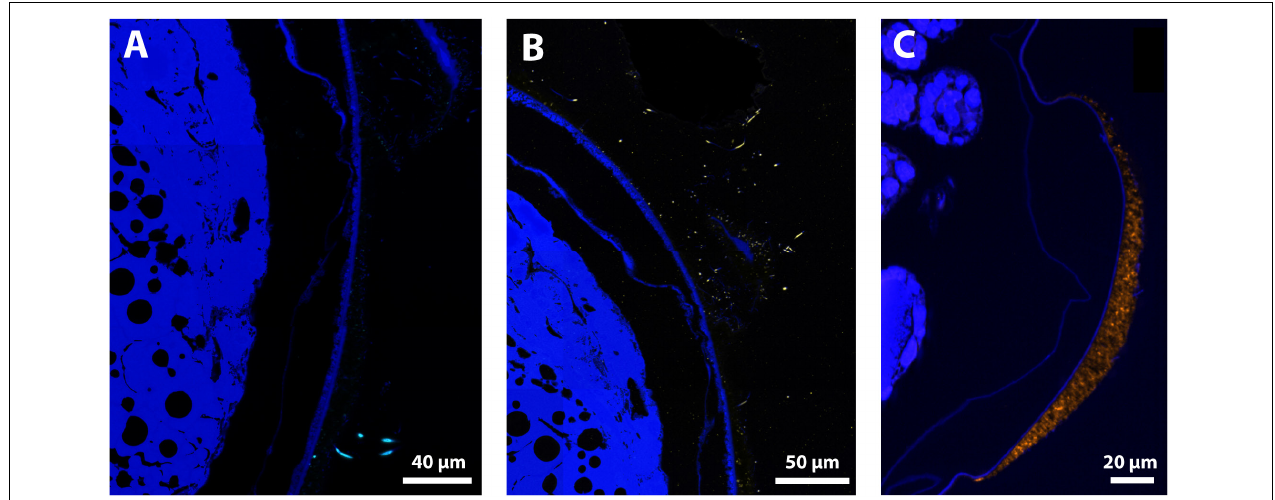
FIGURE 8 | FISH Observations of Rimicaris exoculata late stage eggs with specific probes. Observations were performed on semi-thin sections (2 µ m) stained with DAPI (blue) with eggs from the external part of the brood with abundant mineral deposits, hybridized (A) with Epsi914-Cy5, (B) with Gam42a-Cy5, and (C) with Zeta123-Cy3. Colors = Light Blue ( Epsilonbacteraeota ), Yellow ( Gammaproteobacteria ), and Orange ( Zetaproteobacteria